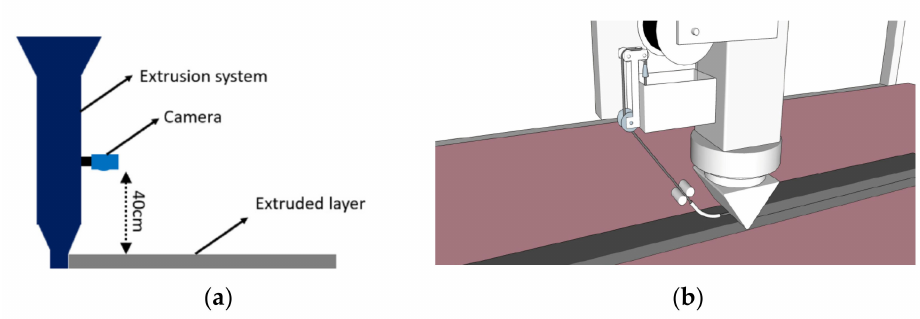
Figure 10. Nozzle accessories. ( a ) a camera is mounted on the nozzle to monitor the extruded layer (Reprinted with permission from Ref. [98]), and ( b ) a cable embedding mechanism is mounted on the nozzle tip (Reprinted with permission from Ref.